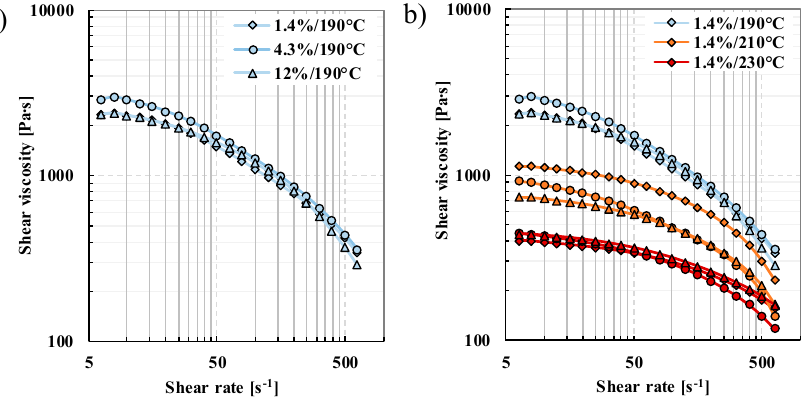
Figure 2. Shear viscosity of Ingeo 4032D (1.4%), 2003D (4.3%), and 4060D (12.0%) PLA ( a ) different D - lactide contents at 190 °C, ( b ) different temperatures (190 °C, 210 °C, and 230 °C).